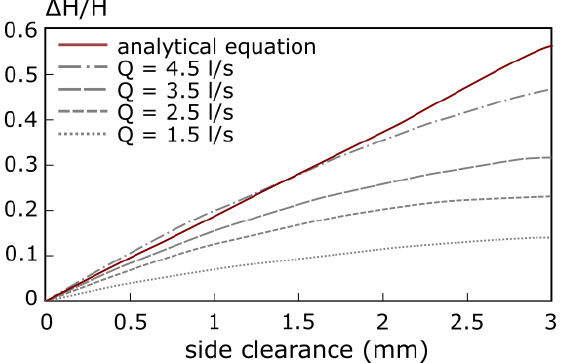
Figure 2. Change of the pump head with increasing the side clearance width